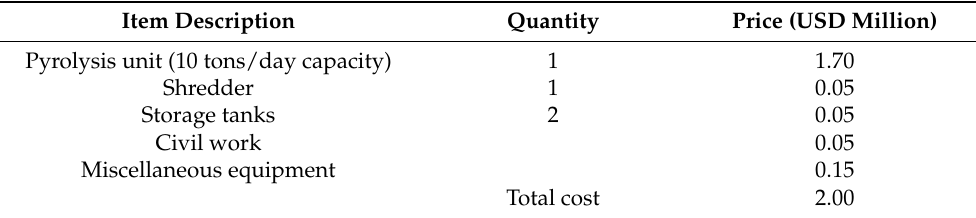
Table 5. The initial cost of pyrolysis unit.